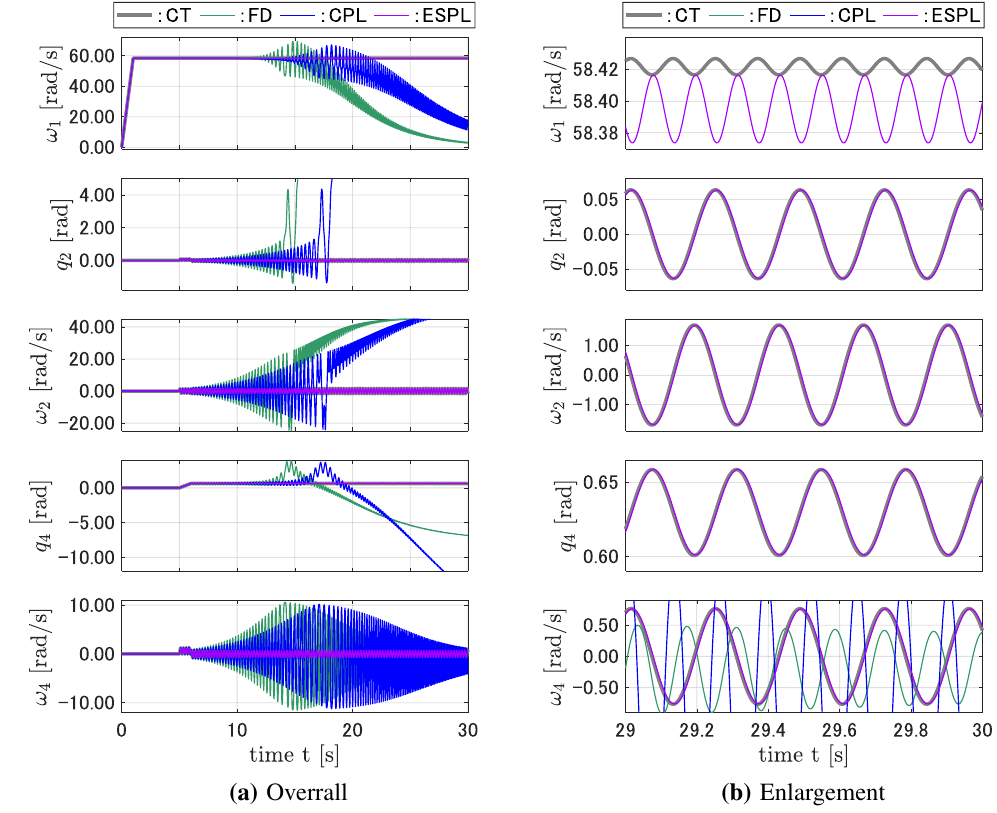
Figure 5. Responses of the CT, FD, CPL, and ESPL models for case